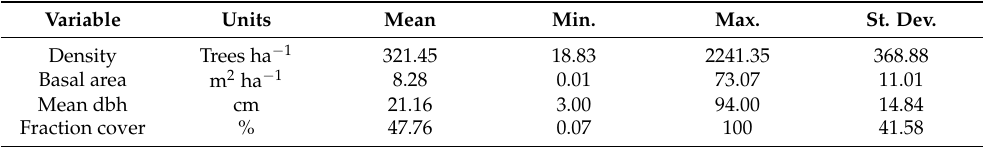
Figure 2. Flowchart used to develop Wildfire Potential Behaviour Indices in complex Mediter- ranean forests. Table 1. Silvicultural variables of forest types in Sierra de las Nieves National Park (M á laga, south- ern